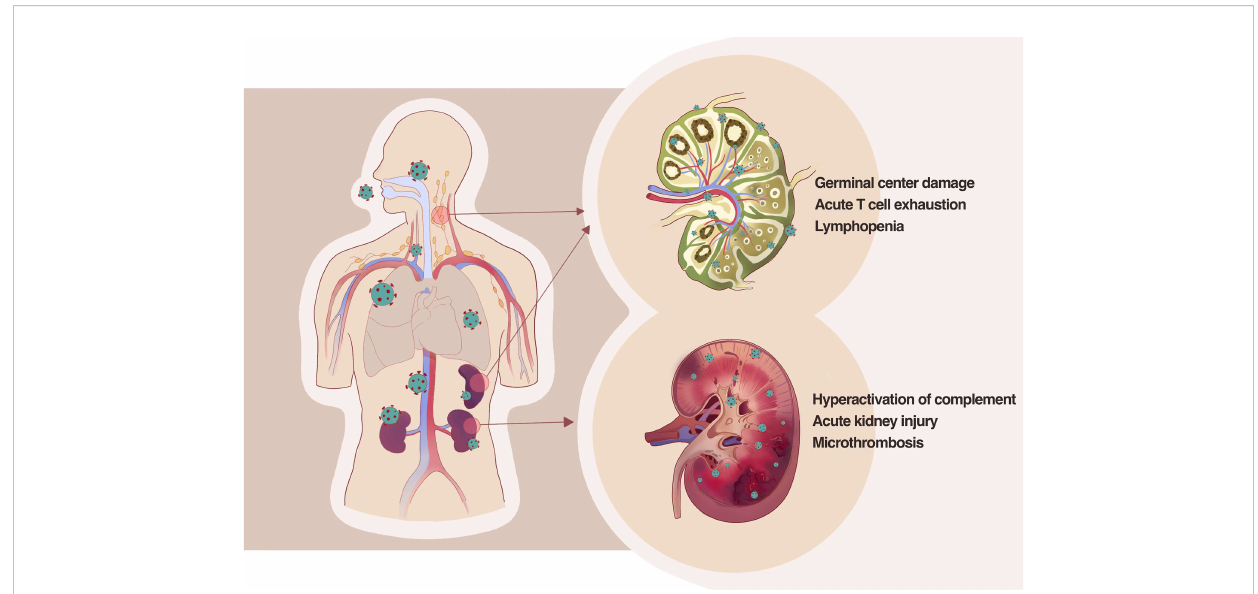
FIGURE 2 SARS-CoV-2 directly infects the human kidney and the second lymphoid tissues, including lymph nodes and spleens, by thus deteriorating tissue damage. SARS-CoV-2 could directly infect secondary lymphoid organs in severe or dead patients leading to the secretion of in fl ammatory factors such as IL-6 and TNF- a in infected cells, which causes necrosis and apoptosis of immune cells and further the quantity reduction of lymphocytes. Pathological examination of kidney tissue from patients with COVID-19 and autopsy revealed that SARS-CoV-2 directly invade human kidney through ACE2 receptor and mediate acute kidney injury and severe tubular